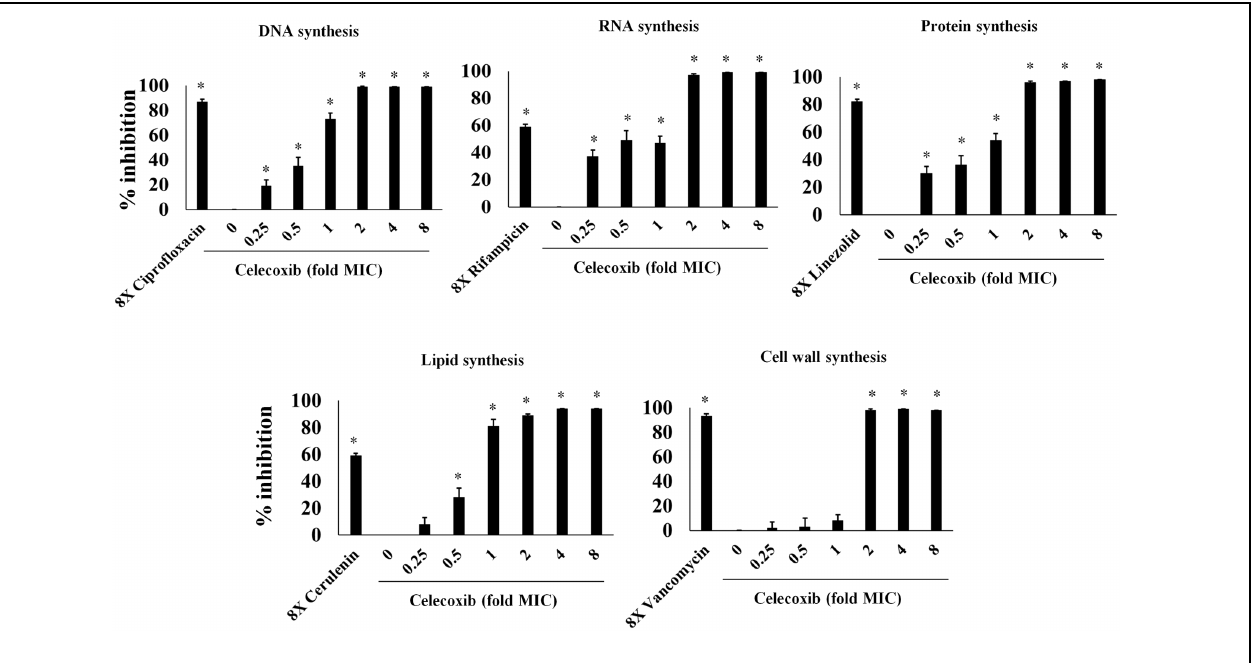
FIGURE 2 | Macromolecular synthesis assay in the presence of celecoxib and control antibiotics. Incorporation of radiolabeled precursors such as [3H] thymidine, [3H] uridine, [3H] leucine, [14C] N -acetylglucosamine and [3H] glycerol for DNA, RNA, protein, cell wall, and lipid synthesis, respectively, were quantified in S. aureus ATCC 29213. Based on the incorporation of radiolabeled precursors, percent of inhibition by celecoxib at